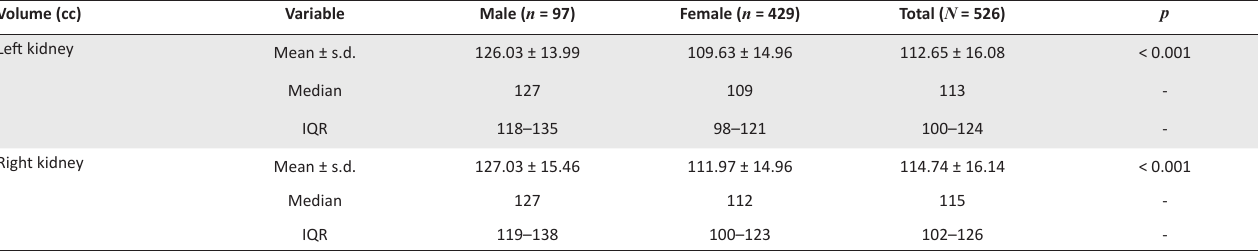
TABLE 1 : Kidney volume and gender. Volume (cc) Variable